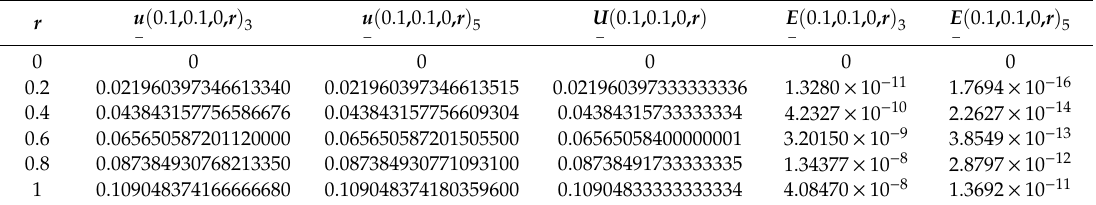
Table 1. Solution and accuracy of third and fifth order double parametric HPM solutions for Equation (24) at t , x = 0.1 and b = 0 for all r ∈ [ 0,1 ] .